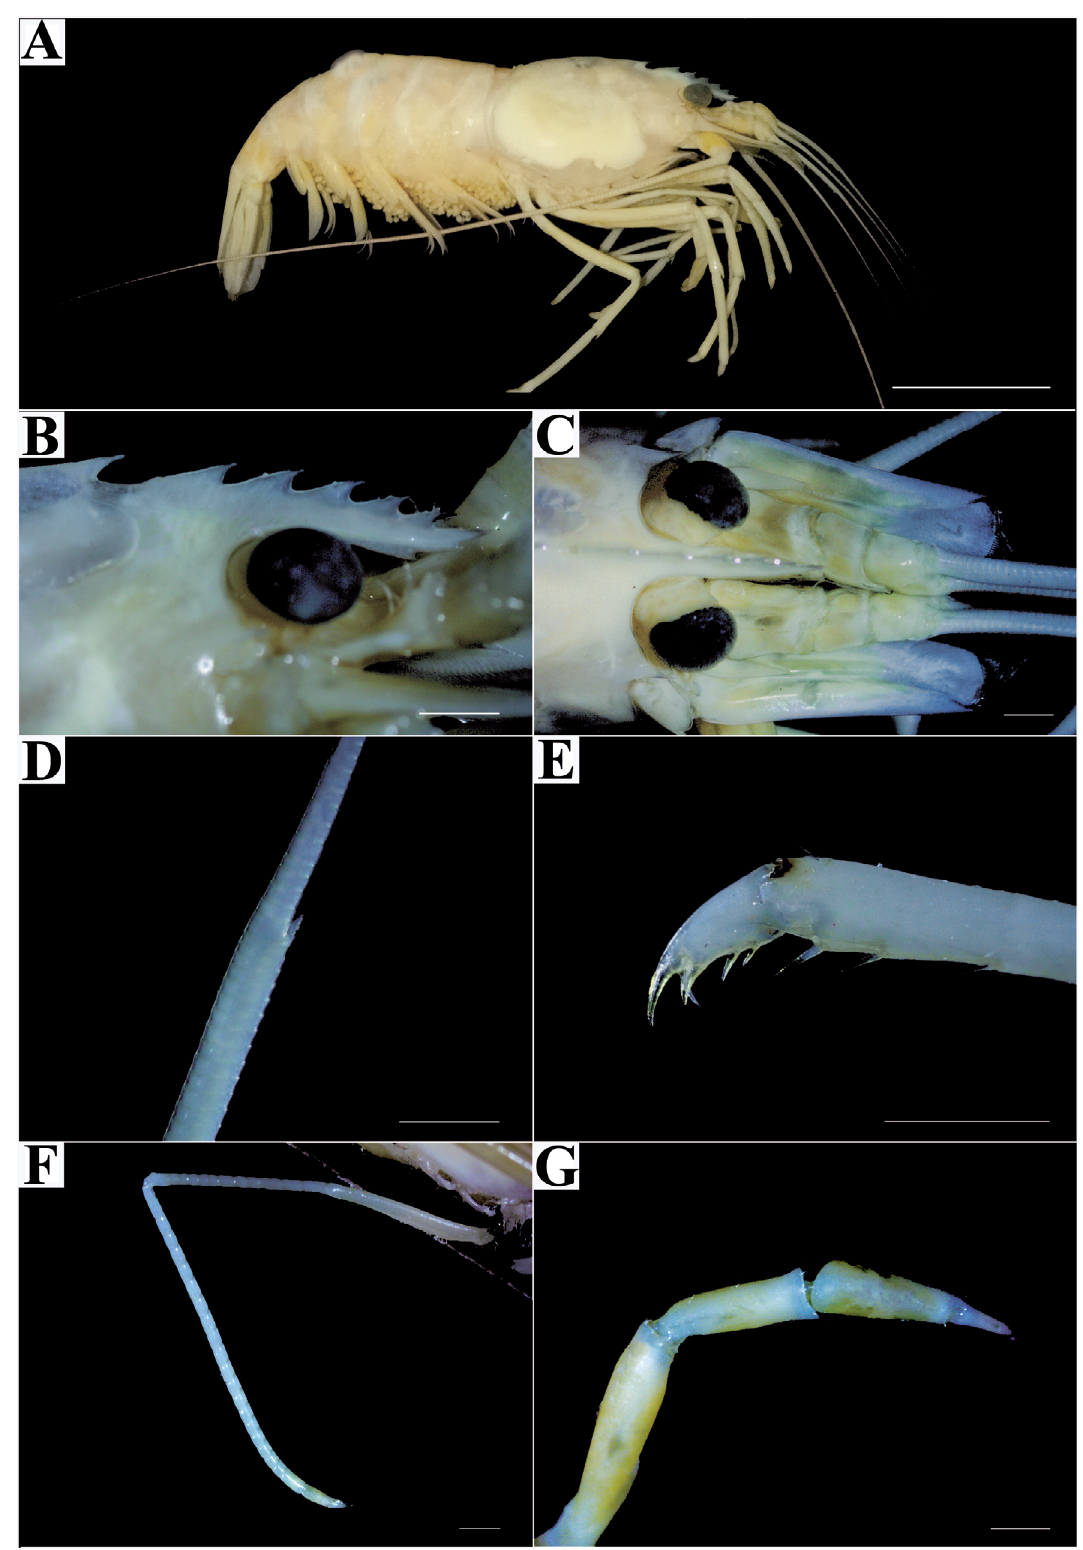
Figure 2. Lysmata uncicornis Holthuis and Maurin, 1952. A , Specimen collected in the area near to the border of the protected area of Queimada Grande Island, lateral view; B , lateral view, rostrum details and absence of pterogostomial spine; C , dorsal view, reach of rostrum in relation to distal margin of third article of antennular peduncle; D , dorsal antennular flagellum with trace of accessory branch; E , dactyl of pereopod 3, lateral view; F , second pereopod, lateral view, number of subdivisions on carpus; G , first pereopod, lateral view, length of carpus in relation to height. Scale bars, A = 1cm; B – F = 1mm. Photographs by R. C.